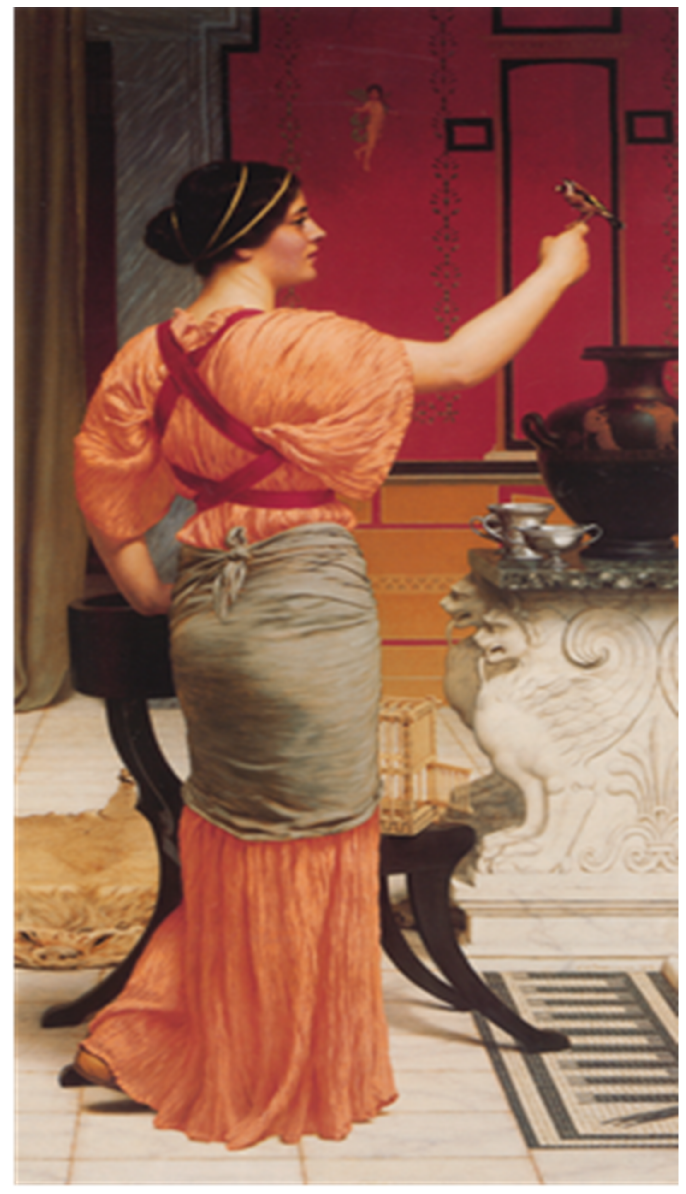
Figure 8. John William Godward. “Lesbia with a Sparrow” (1916).